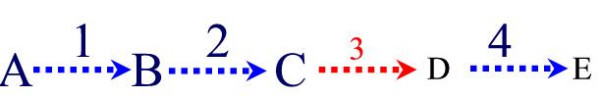
The relationship of the activity of enzymes to their metabolic pathway.